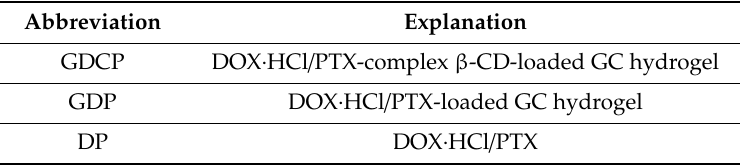
Table 1. Samples for this study.